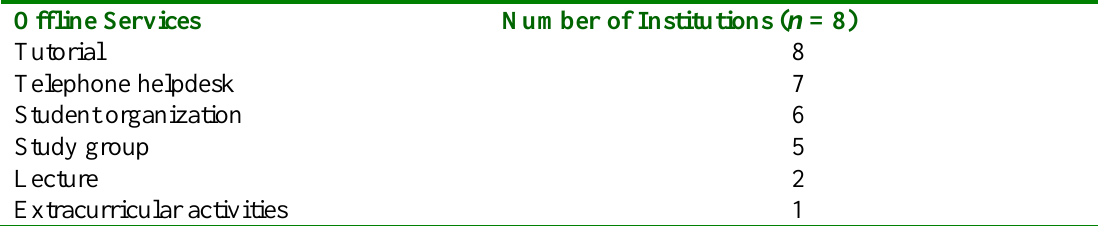
Table 4. Provision of offline learner support services reported by the eight institutions Offline